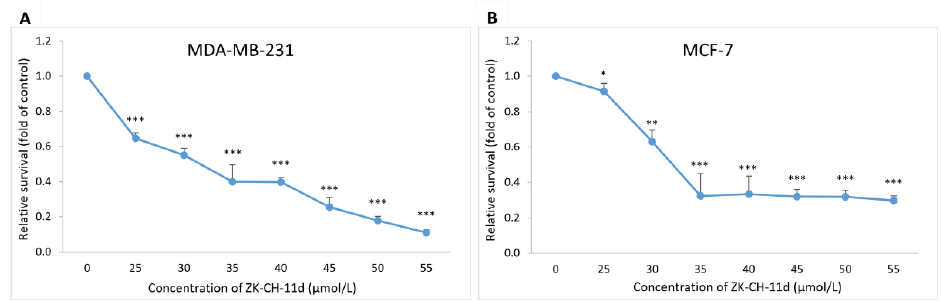
Figure 3. Effect of ZK-CH-11d on BrdU incorporation in MDA-MB-231 and MCF-7 cells. MDA-MB- 231 ( A ) and MCF-7 ( B ) cells were exposed to chalcone at concentrations of 25 –55 μmol/L for 72 h of treatment. The data show the mean values ± standard deviation of three independent experiments. Statistical significance: * p < 0.05, ** p < 0.01, *** p <